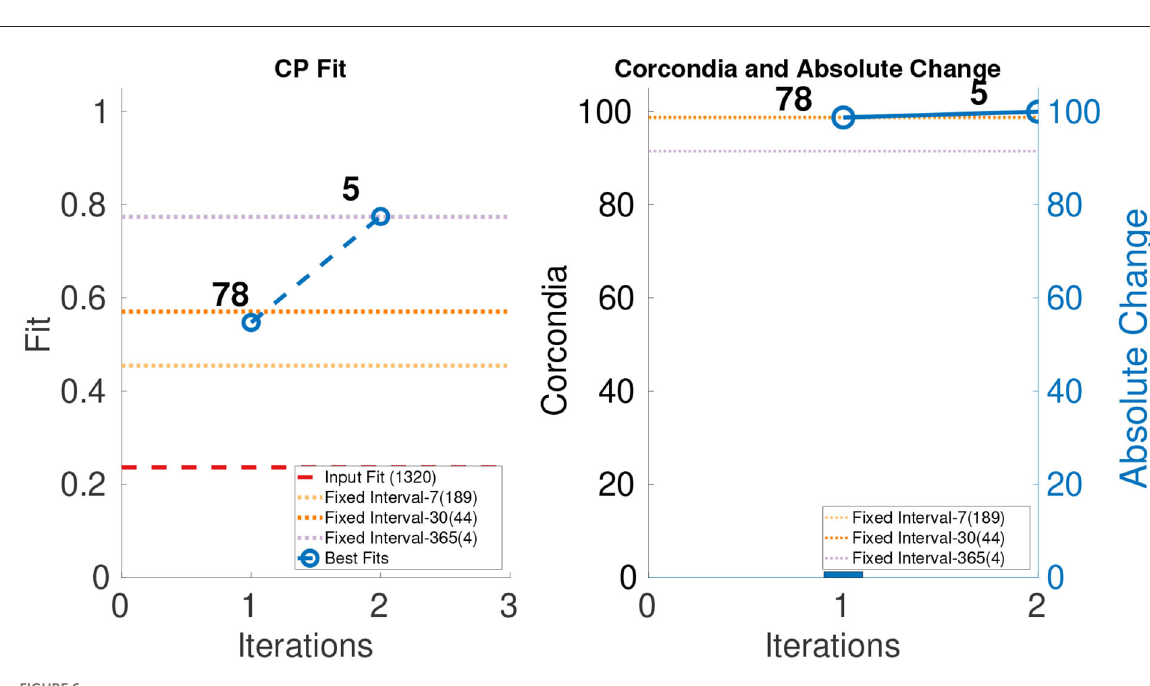
developed a streaming CP decomposition that works on the original granularity of the data, instead of preprocessing the tensor in order to identify one or more optimal aggregations.